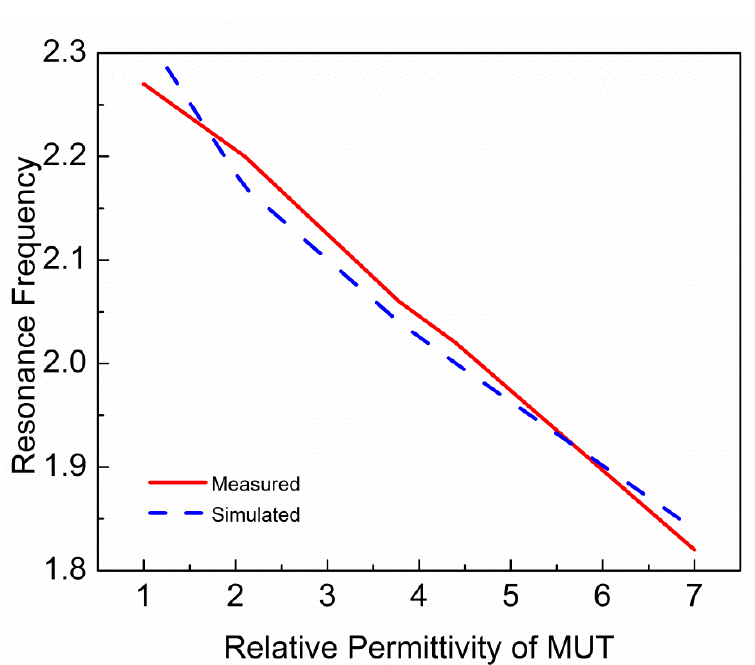
Figure 12. Relative permittivity of MUT versus resonance frequency of the sensor obtained by Electromagnetic (EM) simulation and VNA measurement. Relative permittivity of MUT is inversely proportional to the resonance frequency of sensor.